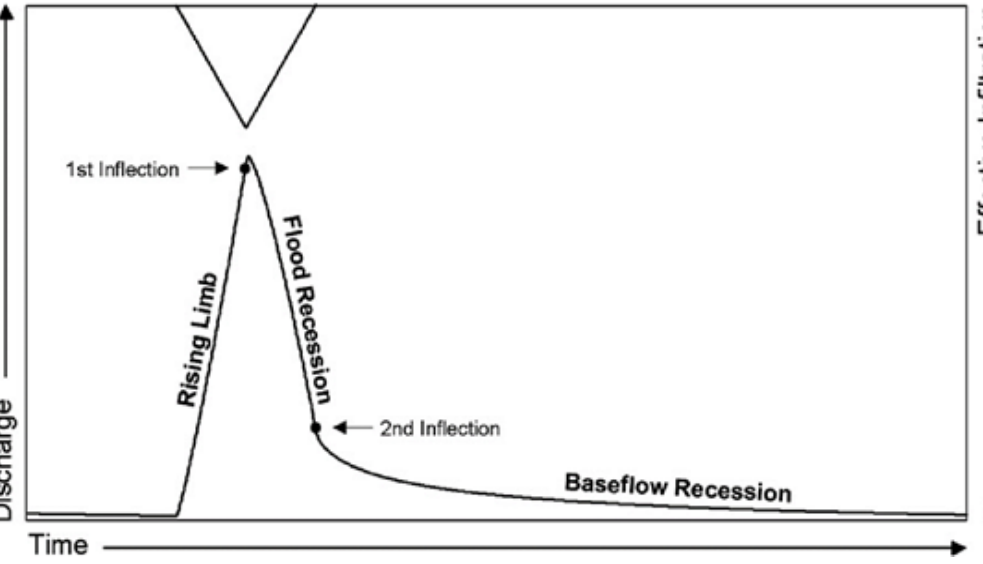
Figure 2. Schematic representation of a spring hydrograph (modified from Kovács and Perrochet [ 43 ] ).